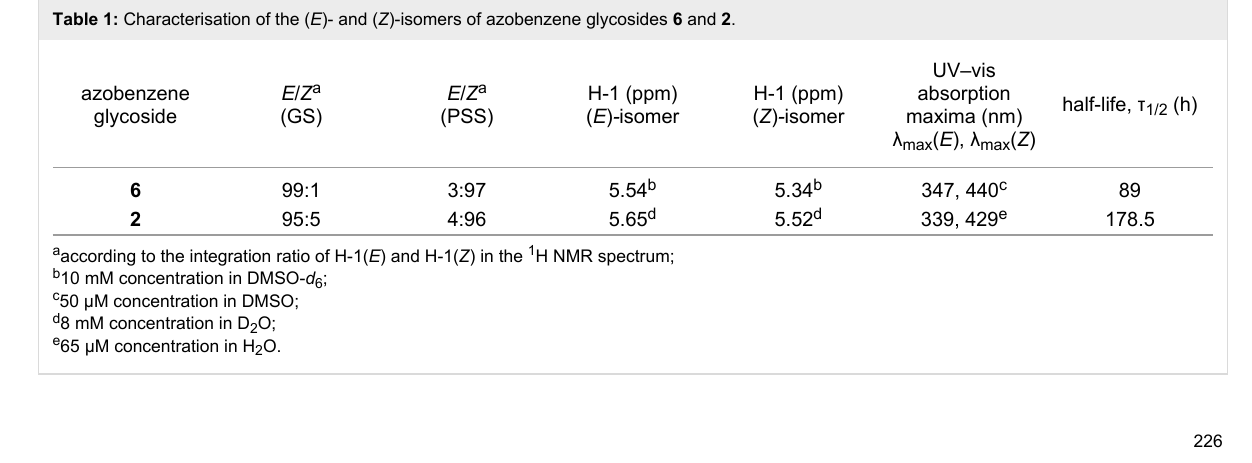
Table 1: Characterisation of the ( E )- and ( Z )-isomers of azobenzene glycosides 6 and 2 .